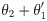
Example paths for each pattern of hidden states.The particle of interest moves from left to right, and is observed at times (k − 1)Δt, kΔt, and (k + 1)Δt. In a), there are no reorientation events, so the particle continues along a straight trajectory. In b), there is a single reorientation in the time interval [kΔt, (k + 1)Δt), where the particle turns through an angle ϕ, but the observed angle change is θ1 due to the discrete nature of the observations. In c), there is a single reorientation in the time interval [(k − 1)Δt, kΔt). The particle turns through an angle ϕ and continues on its new trajectory. We observe an angle change θ1 for the time interval [(k − 1)Δt, kΔt), and observe an angle change θ2 for the next time interval [kΔt, (k + 1)Δt) even though there was no reorientation during this time interval. Similarly, in d), there was a reorientation of true angle change ϕ during [(k − 1)Δt, kΔt) followed by another reorientation of true angle change ϕ′ in the time interval [kΔt, (k + 1)Δt). In this case, we observe angle change θ1 for the time interval [(k − 1)Δt, kΔt), and observe an angle change of θ2+θ1′ for the time interval [kΔt, (k + 1)Δt).